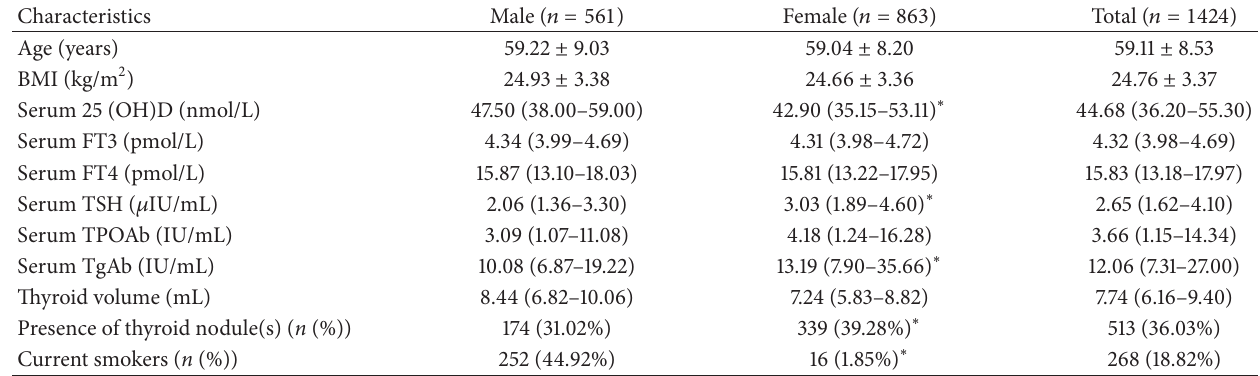
Table 1: Clinical and laboratory characteristics of the participants.